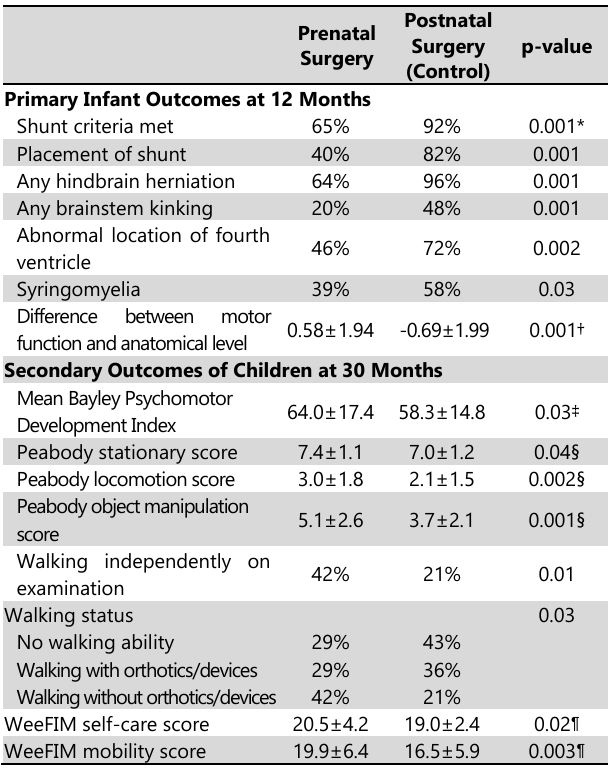
Table 1 . MOMS Statistically Significant Outcomes Comparison between the Prenatal and Postnatal (control) Cohorts at 12 Months Postnatal for Primary Outcomes and 30 Months for Secondary Outcomes.